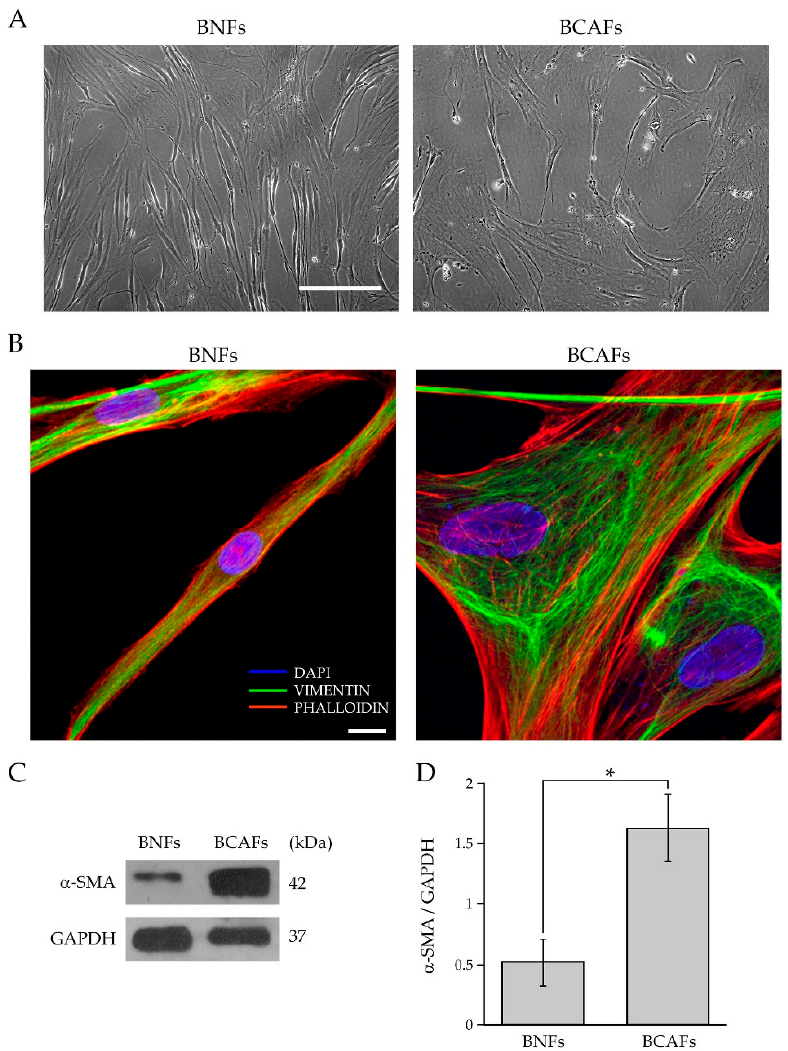
Figure 1. Characterization of fibroblasts isolated from normal and cancerous human breast tissues. ( A ) Representative cell morphology of BNFs and BCAFs by phase-contrast microscopy. Scale bar 200 µ m. Magnification × 10. ( B ) Analysis of the cytoskeletal organization of BNFs and BCAFs by confocal fluorescence microscopy. Vimentin immunofluorescence (green channel) and phalloidin staining (red channel) of representative BNFs and BCAFs. DAPI (blue channel) was used to locate the nuclei. Images correspond to the 3D reconstruction of Z planes acquired from the top to the bottom of cells. Scale bar 10 µm. The images are representative of three independent experiments. ( C ) Western blotting analysis of α -SMA in protein extracts of BNFs and BCAFs; GAPDH was used as the loading control. A representative image of three independent experiments is shown. ( D ) Densitometric analyses of α -SMA protein levels. Data are reported as means of at least three independent experiments ± S.E.* p <